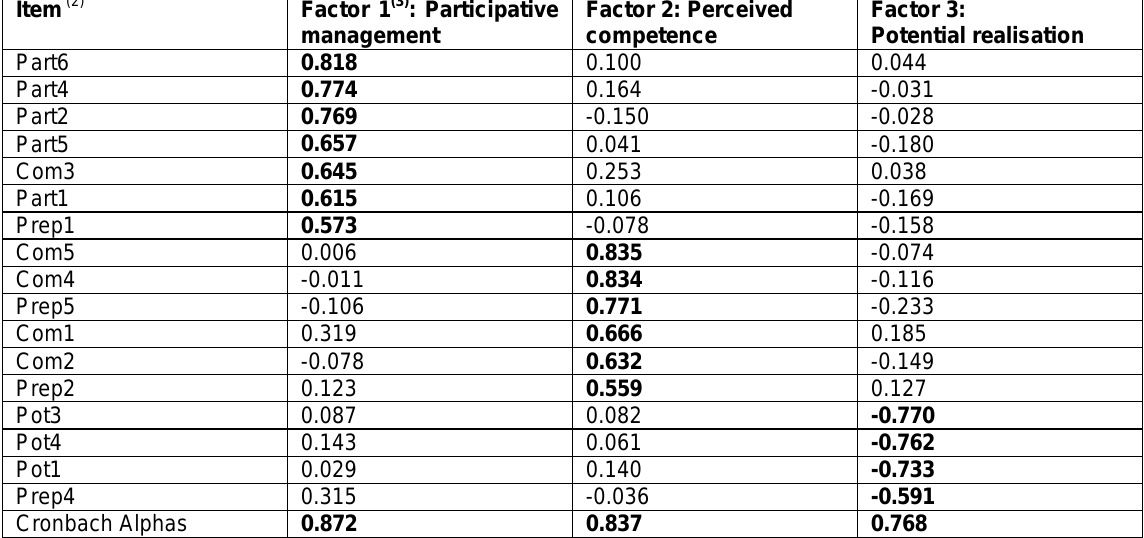
Table 1: Pattern matrix of Oblimin rotated-principal component factor analysis